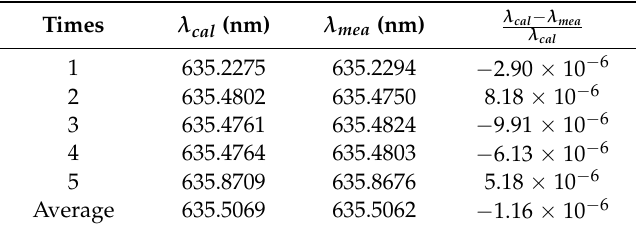
Figure 16. Relationship between λ cal and the variation of slope k cal , and between λ cal and the variation of the drift of positive first-order diffraction angle. Table 1. Calibrated and measured laser wavelength.